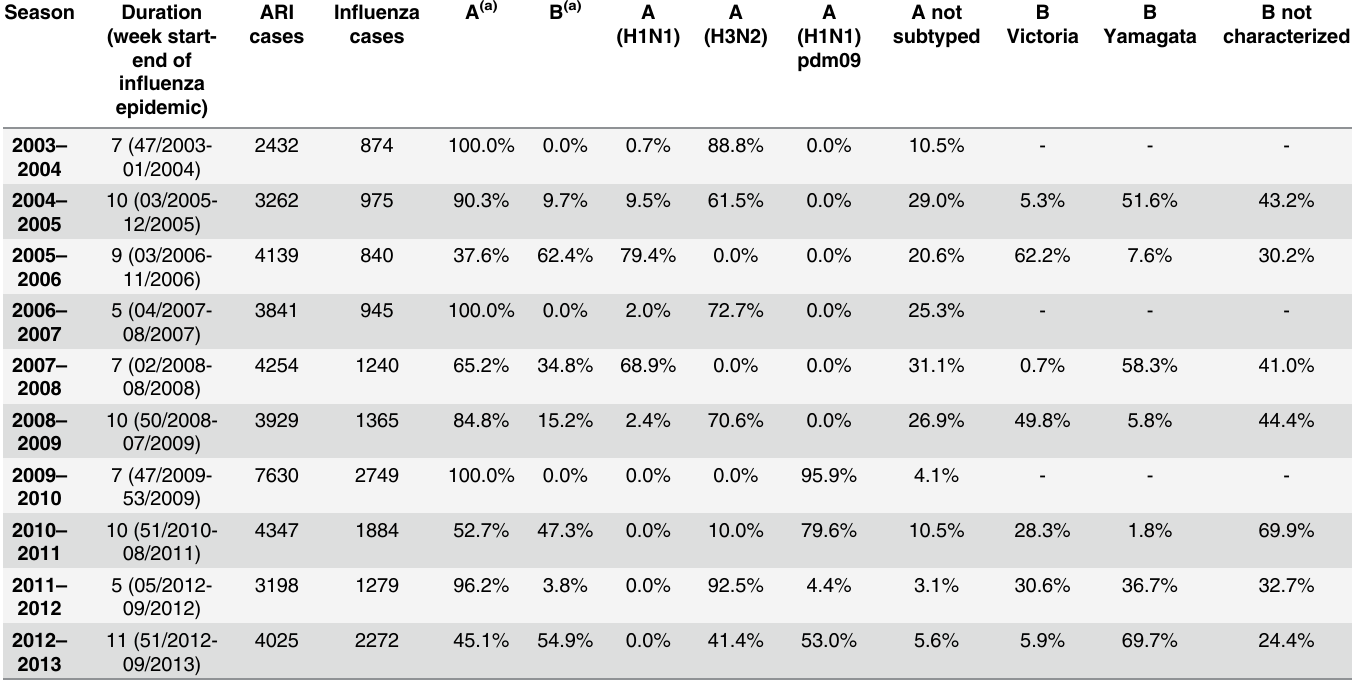
Table 1. Number of swabbed ARI and influenza cases, and percentages attributable to different influenza virus types and subtypes/lineages, in the IBVD (Influenza B in Vircases database) study. France, 2003 – 2004 to 2012 – 2013.